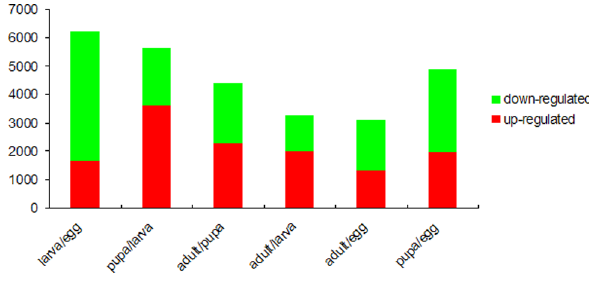
Figure 4. Numbers of DGE unigenes in each comparison. doi:10.1371/journal.pone.0073911.g004 PLOS ONE |